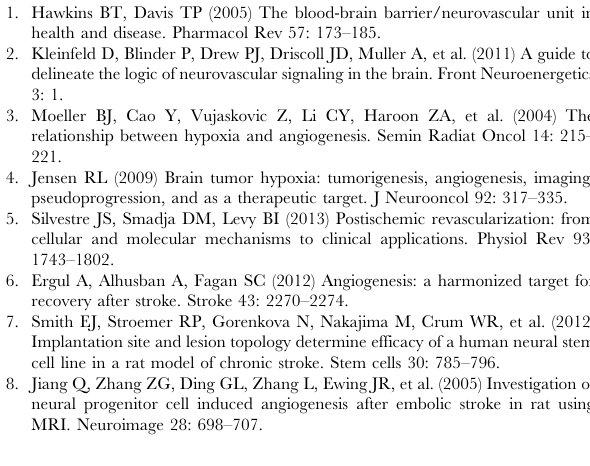
Table S1 Composition of culture media. Composition of the cell culture media for growing the D3 human cerebral microvascular endothelial cell (hCMEC) line, the STROC05 human neural stem cell (hNSC) line, and the hCMEC/hNSC coculture. Factors with a * were removed to induce cell